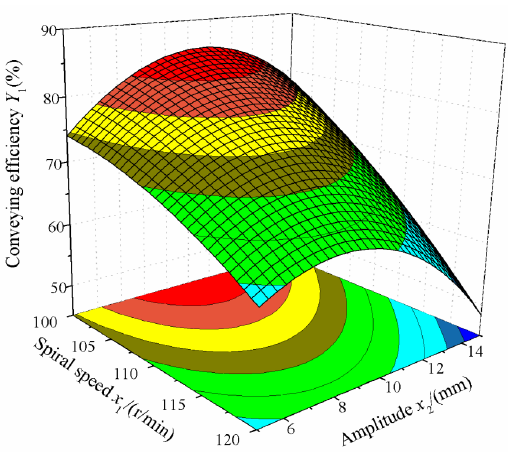
Figure 13. Influence of factor interaction on conveyance efficiency.